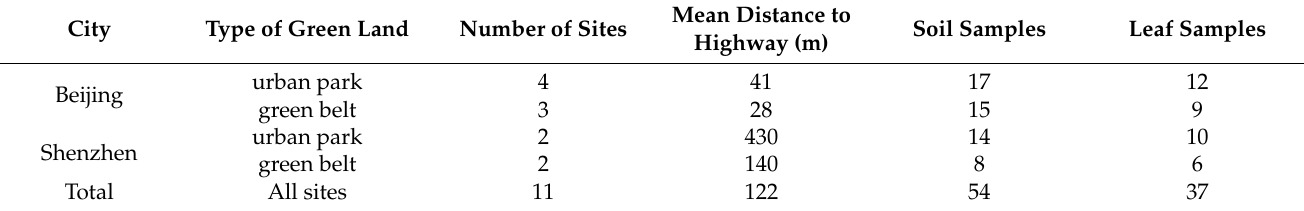
Table 2. Detailed information on the sampling